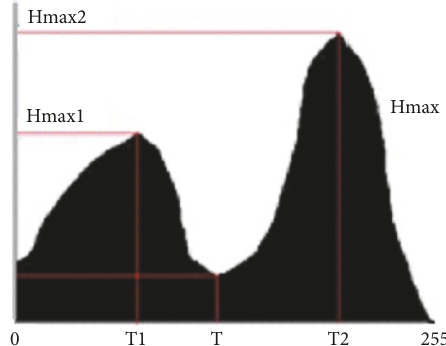
Figure 3: Schematic diagram of 2-Mode segmentation method.